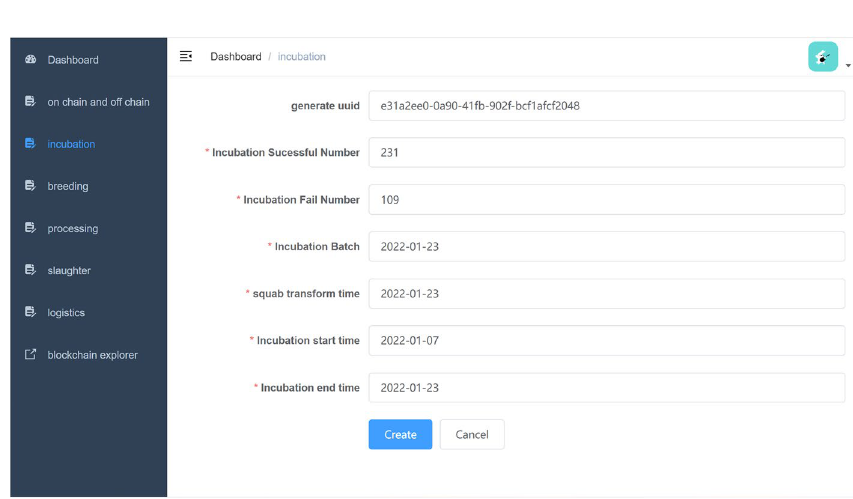
Figure 6. Incubation